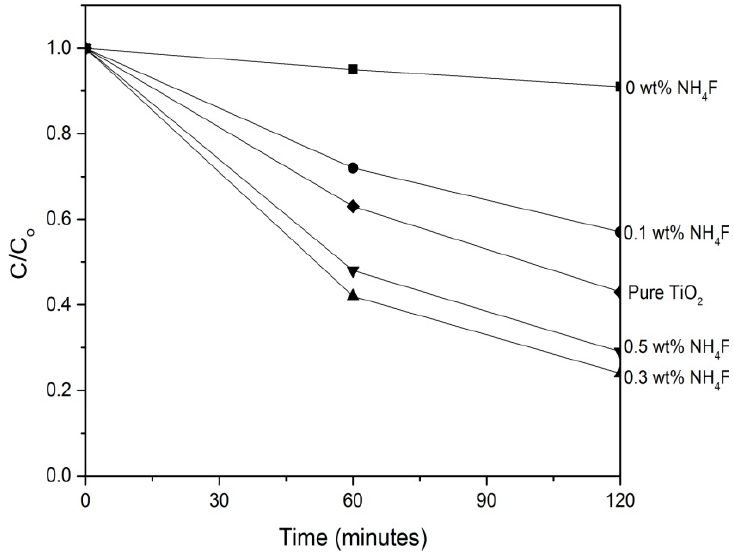
-TiO nanotubes and pure TiO nanotubes. 3 2 2